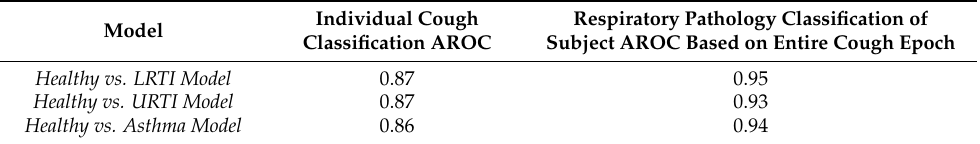
Table 6. Area under the receiver operating curve (AROC) for Healthy vs. LRTI Model , Healthy vs. URTI Model , Healthy vs. Asthma Model